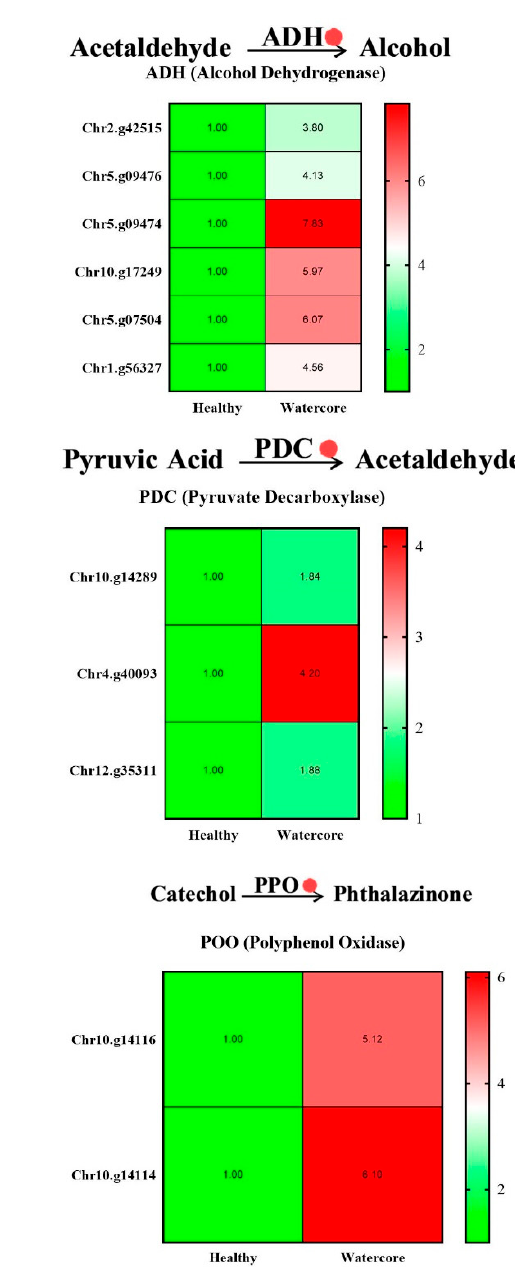
Figure 4. Analysis of ethanol, acetaldehyde and total phenols content ( A ) and their metabolism-related gene expressions ( B ) in watercore fruit. The red circle refers to the up-regulation of gene expression. The asterisk on the bars indicates significant differences between the watercore and healthy fruit at p < 0.05. UD: Not detected.